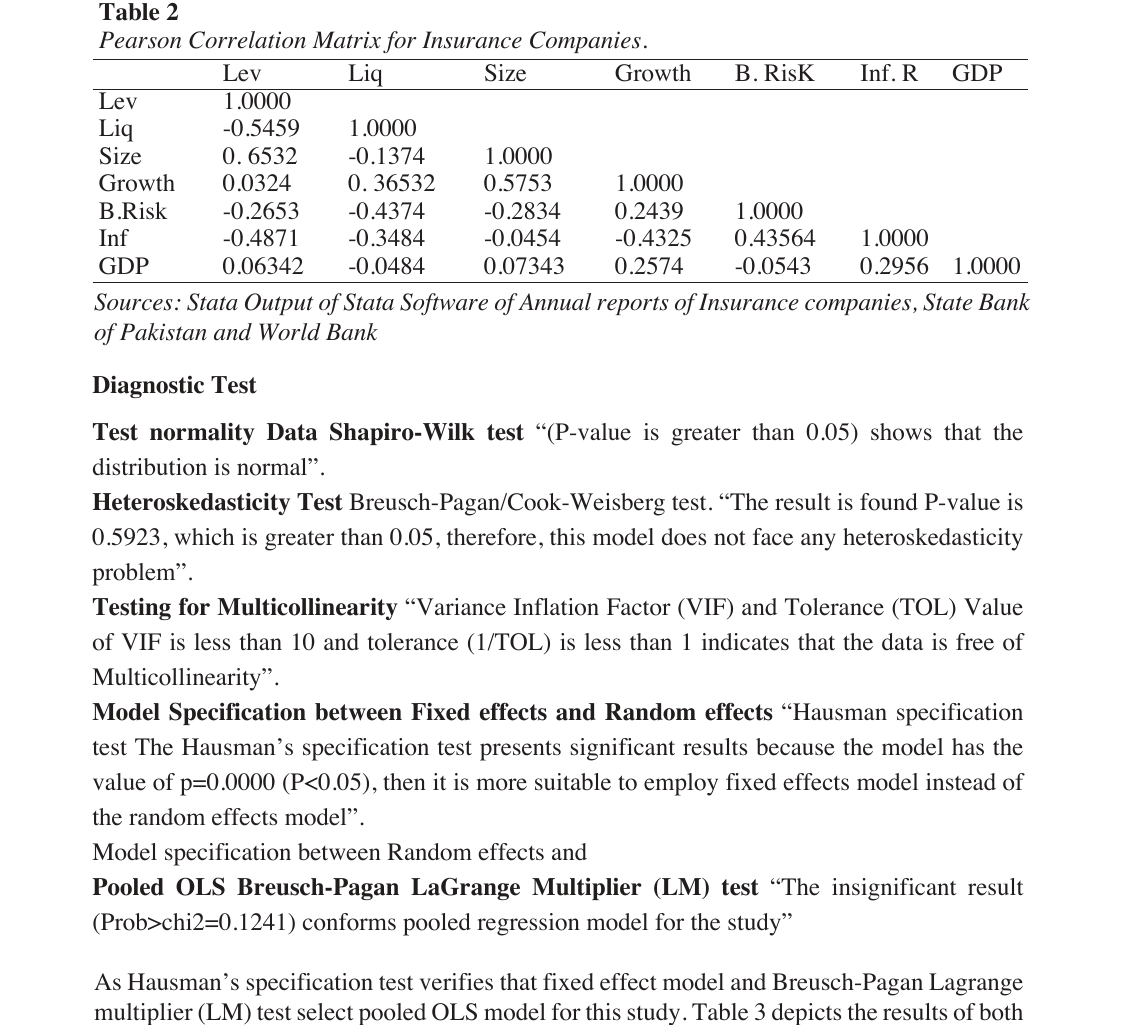
Pearson Correlation Matrix for Insurance